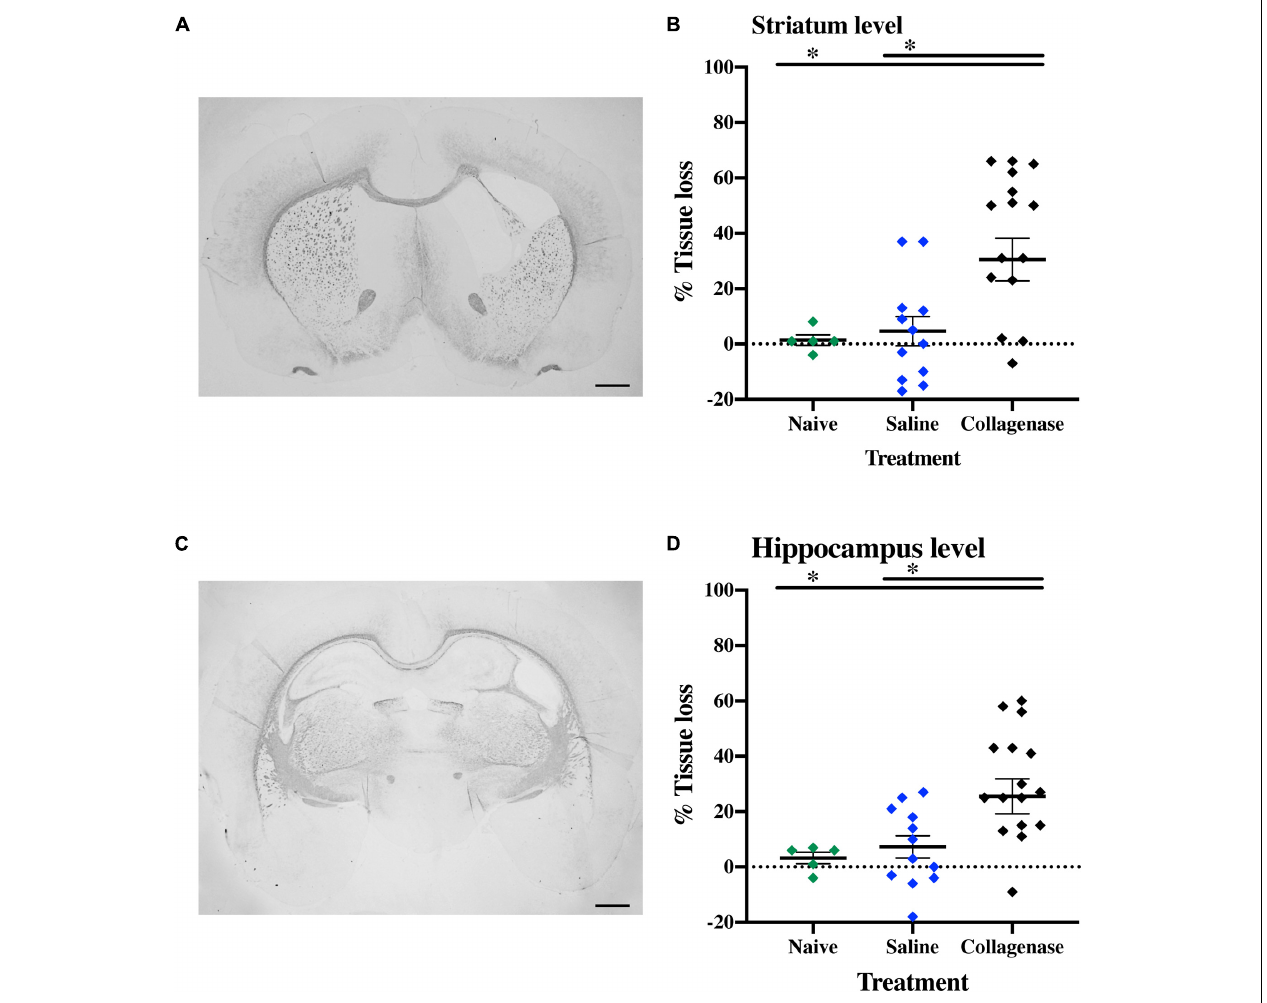
FIGURE 10 | Long term white matter injury at P40. (A) Representative MBP-stained whole brain micrograph of 0.3 U collagenase-injected rats at the level of the striatum and (B) corresponding graph demonstrating collagenase-mediated reduction in subcortical white matter at P40. (C) Representative MBP-stained whole brain micrograph of 0.3 U collagenase-injected rats at the level of the hippocampus and (D) associated graph showing subcortical white matter in the collagenase group ( n = 19) at P40. Both naïve ( n = 5) and saline ( n = 12) animals were used as control groups. Data represented as individual animals ± SEM and analyzed using one-way ANOVA followed by Tukey’s multiple comparison test. ∗ P < 0.05. Scale bar = 1